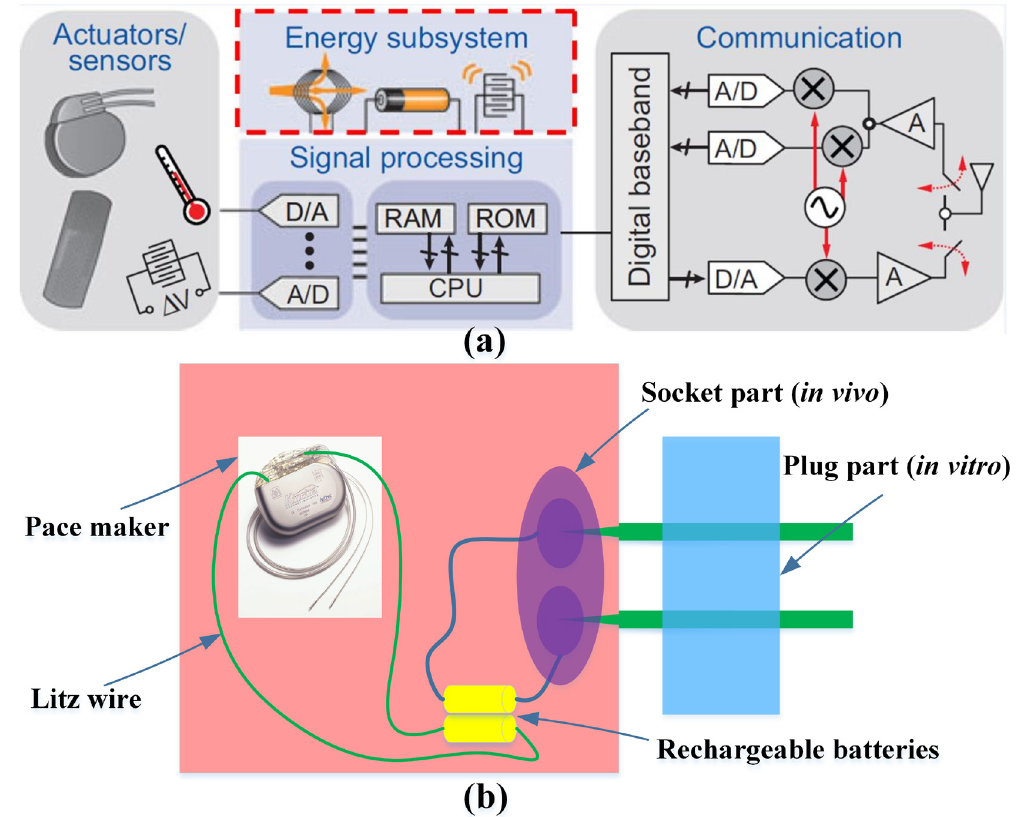
Figure 1. ( a ) The conceptual diagram of a typical implantable microsystem and ( b ) the schematic diagram of the proposed transdermal power transfer